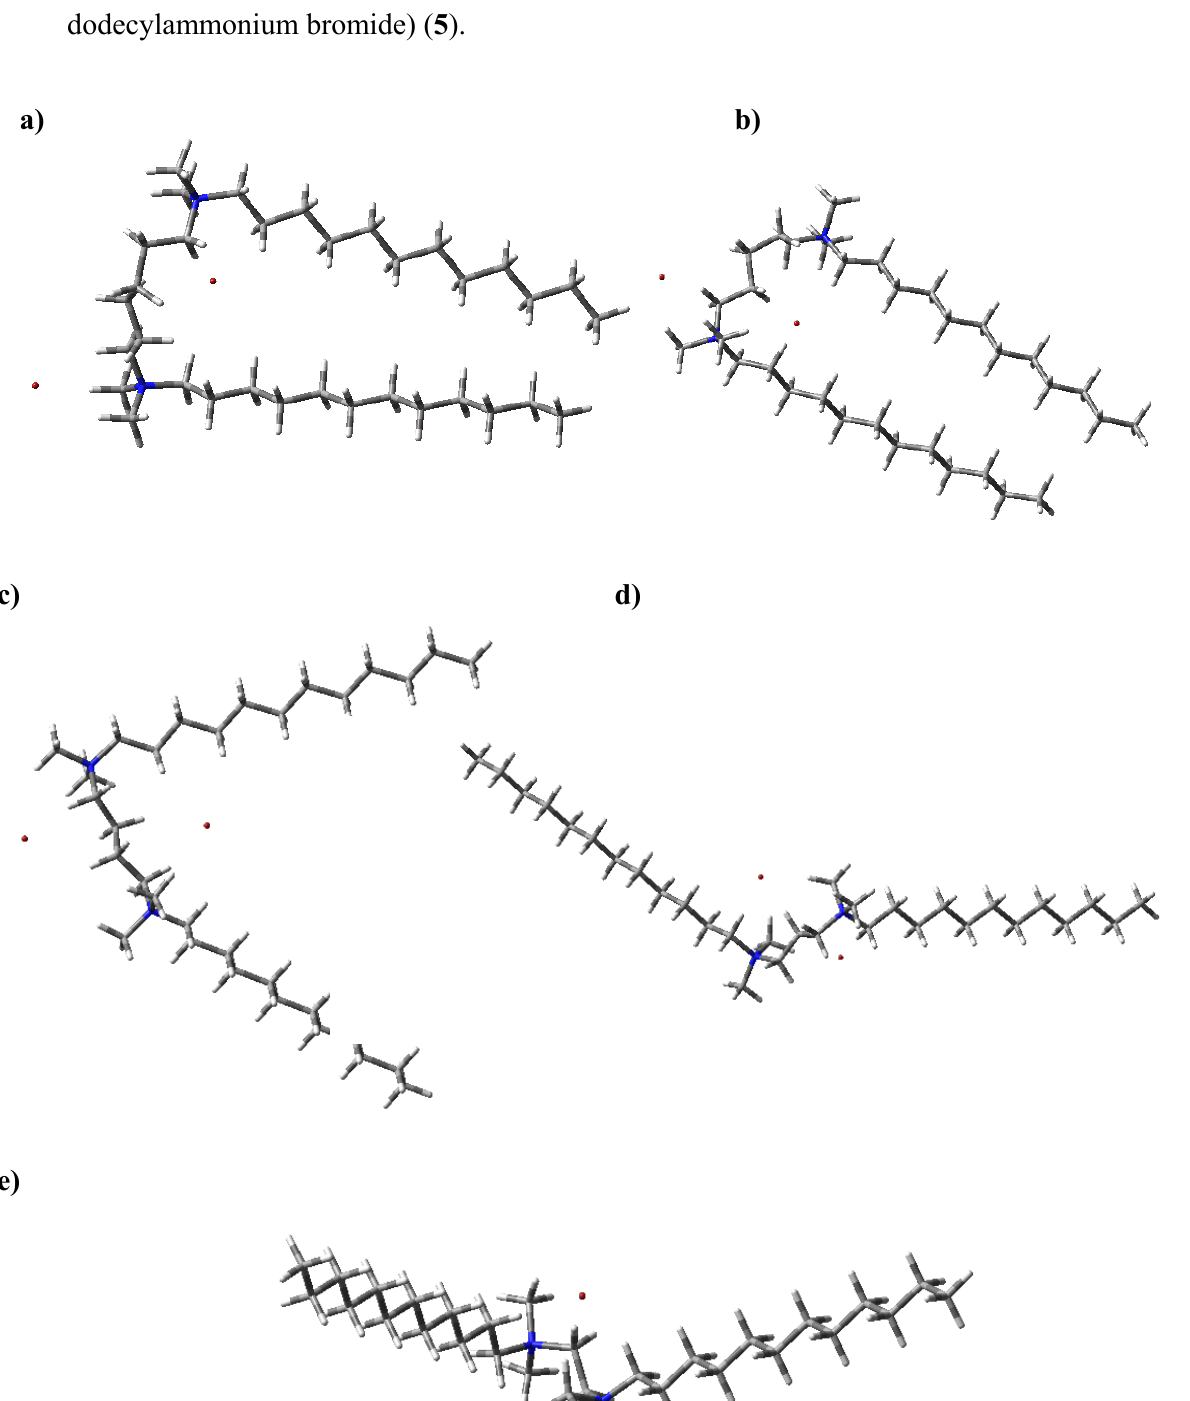
Figure 3. Structures of 1-5 optimized by the Hartree-Fock/3-21G(d,p) method; (a) hexamethylene-1,6-bis( N,N -dimethyl- N -dodecylammonium bromide) ( 1 ), (b) penta- methylene-1,5-bis( N,N -dimethyl- N -dodecylammonium bromide) ( 2 ), (c) tetramethylene- 1,4-bis( N,N -dimethyl- N -dodecylammonium bromide) ( 3 ), (d) trimethylene-1,3-bis( N,N - dimethyl- N -dodecylammonium bromide) ( 4 ) and (e) ethylene-1,2-bis( N,N -dimethyl- N - dodecylammonium bromide) ( 5